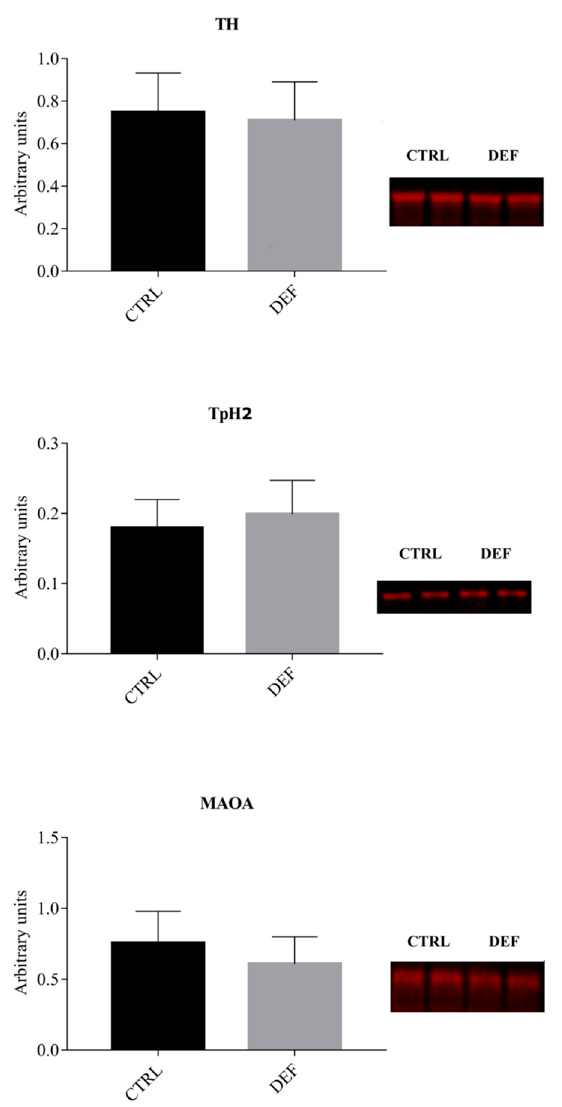
Figure 2. Monoamine synthesizing proteins in the hippocampus. The figure shows the levels of markers associated with monoaminergic neurotransmission in the hippocampus as detected by Western blotting. MAOA may be approaching a decrease in DEF ( p = 0.0844), albeit not reaching significance. The expression of the other investigated markers was not different between groups. Data is displayed as mean ± SD and analyzed by Student’s t -test. TH: Tyrosine hydroxylase; TpH2: Tryptophan hydroxylase 2; MAOA: Monoamine-oxidase A; CTRL: Control animals ( n = 13); DEF: Deficient animals ( n = 12). To evaluate an effect of vitC deficiency on markers of synaptic function (both pre- and postsynaptic), the expression of synaptophysin, NMDAR1, PSD-95 and GluR1 was investigated by Western blotting. A significant decrease in synaptophysin in the DEF group was evident ( p = 0.0160), while NMDAR1 approached a decrease in DEF ( p = 0.0525) (Figure 3), albeit not reaching statistical